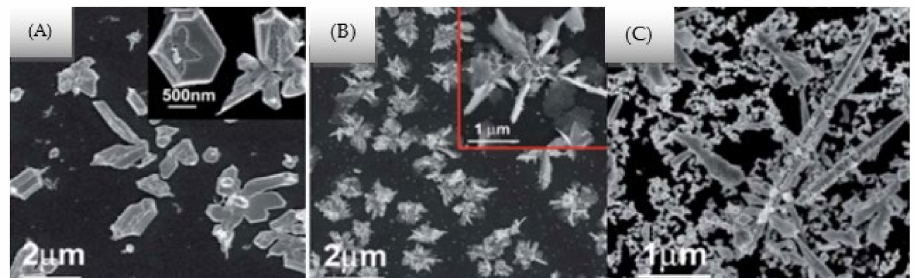
Figure 12. Scanning electron microscopy images of Ag films produced in Si wafer after varying the current densities at ( A ) 2, ( B ) 10, and ( C ) 200 µ Acm − 2 . Adapted with permission from Ref. [168]. Copyright 2011, RSC Pub.